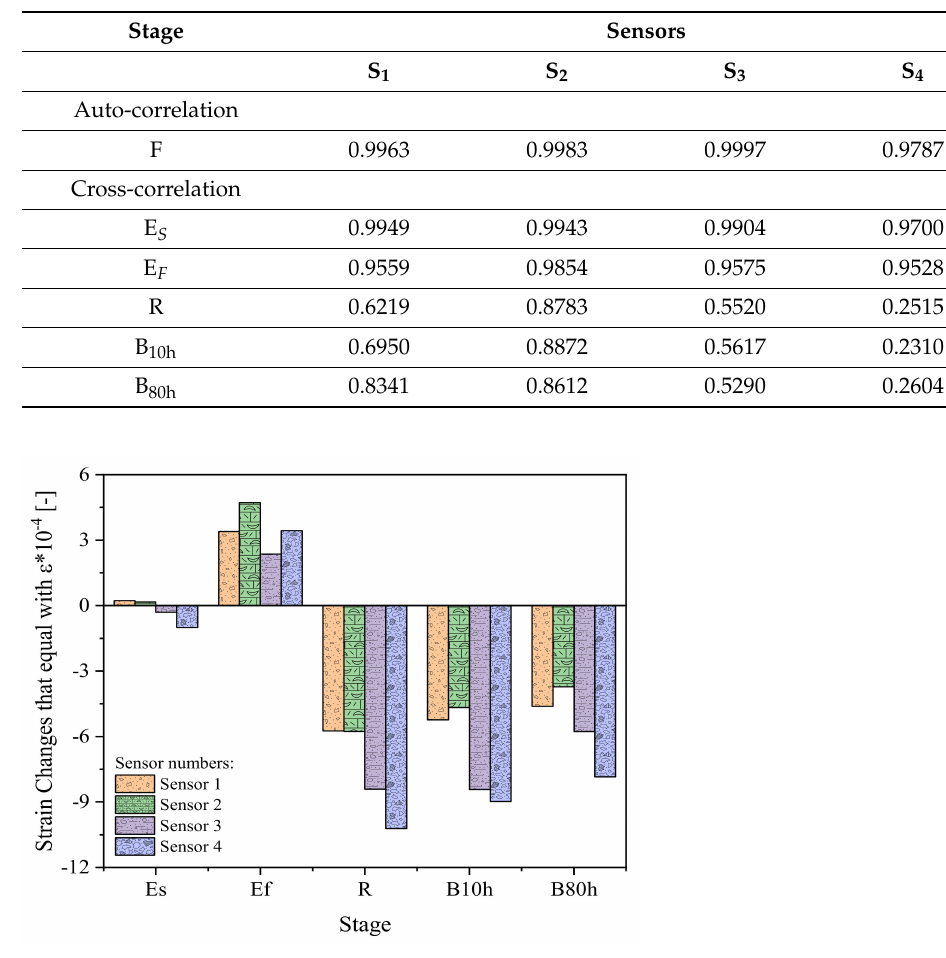
Figure 33. Measured strain changes by FBG sensors according to the defined research stages